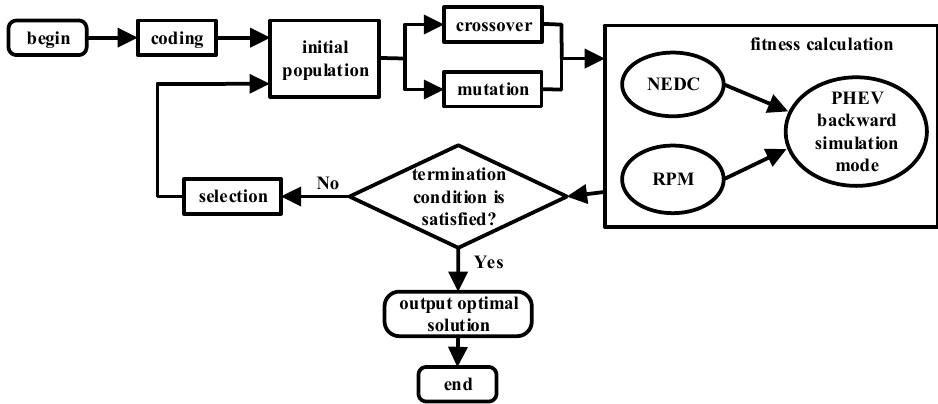
Figure 14. Framework of the bi-level nested parameter optimization method.